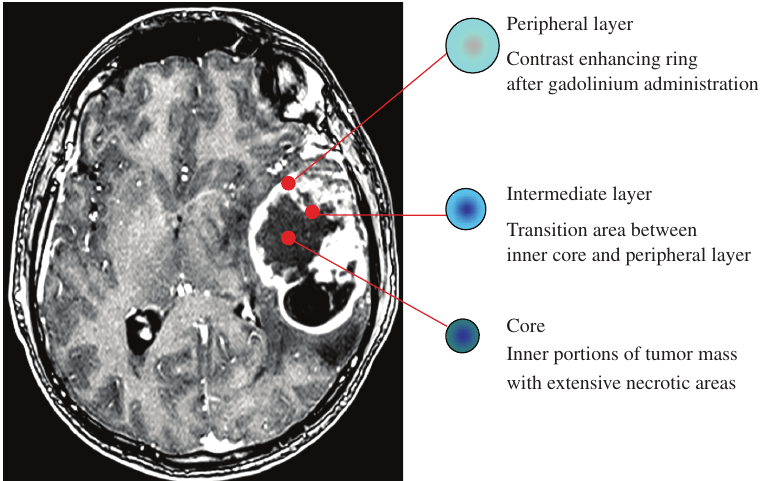
FIGURE 1: The three GBM layers identified by MRI analysis. Through radiological imaging we identified three layers in the GBM mass, classified as core, intermediate layer, and peripheral/hyper-vascularized tumor area. The intermediate area has been considered as the transition area in between the inner core and the peripheral layer (contrast enhancing ring). The surgical procedure was monitored by intraoperative imaging (neuronavigational setting). The neurosurgical resection of the peripheral regions had been done along the tumor/normal brain interface with the effort to avoid normal cells to be included in the